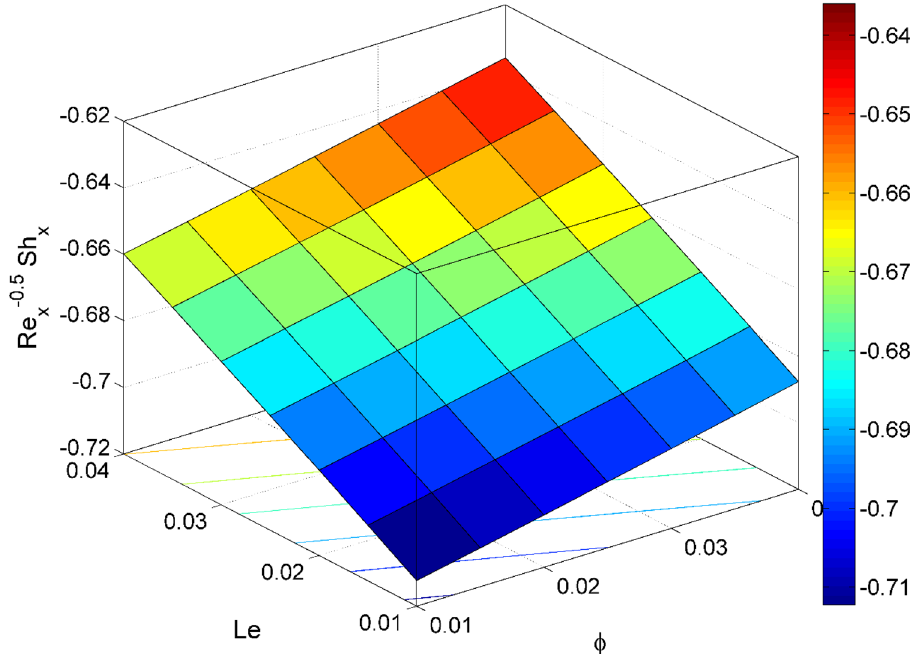
Figure 22. Re − 0.5 y Sh x behavior for the variation of Lewis number Le and nanoparticles volume fraction φ